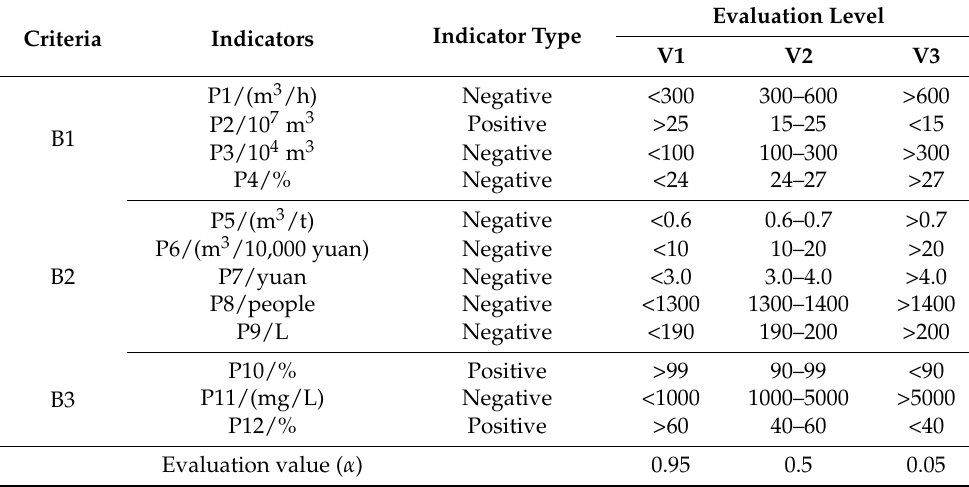
Table 3. Grading criteria of indicators evaluation